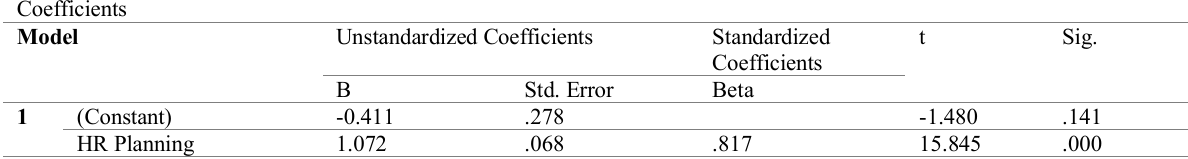
Table 6: Regression Results of effect of human resource planning on firm